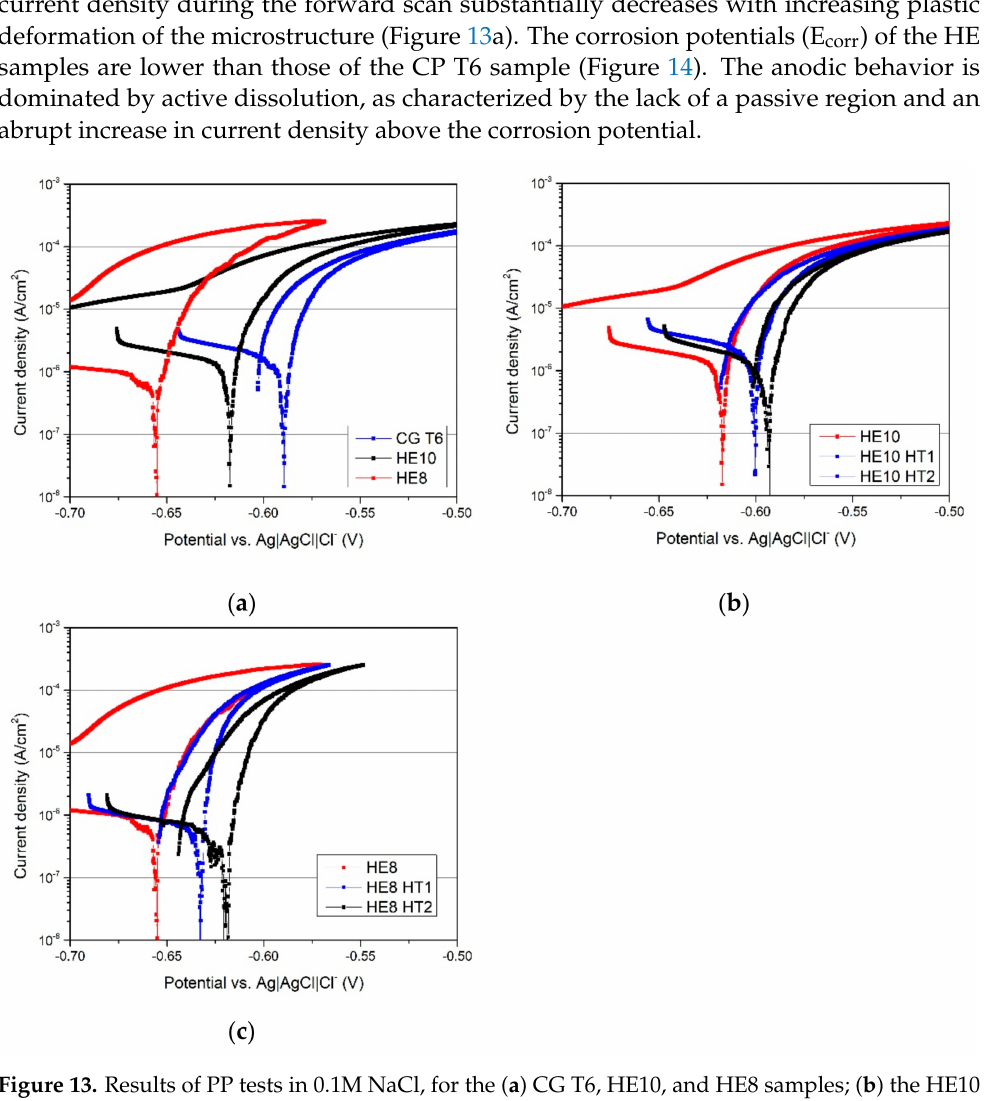
Figure 13. Results of PP tests in 0.1M NaCl, for the ( a ) CG T6, HE10, and HE8 samples; ( b ) the HE10 sample before and after aging; and ( c ) HE8 sample after